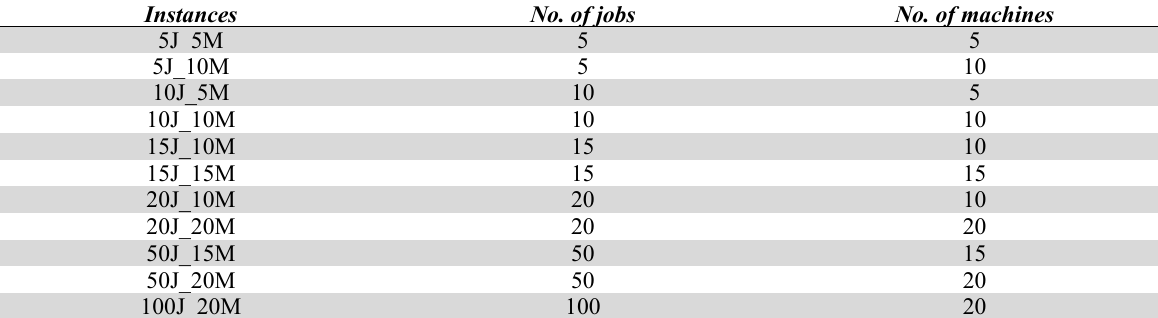
Detail of the test instances